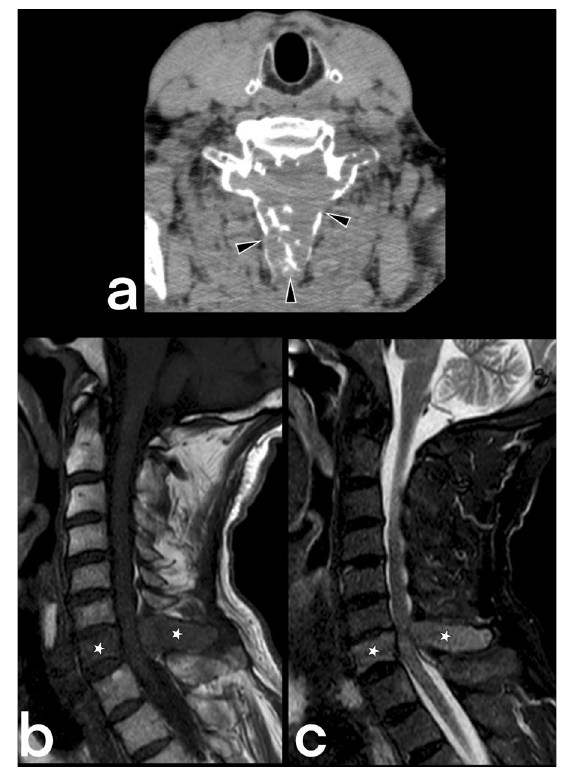
Fig. 46 A 41-year-old male with pain in the posterior neck region. Non-contrast axial CT image ( a ) demonstrates destruction and bone erosion of the posterior spinous process of the C7 vertebra (arrowheads). Pre-contrast sagittal T1 weighted image ( b ) reveals diffuse decreased signal intensity within the c7 vertebral body and posterior spinous process. The lesion shows prominent diffuse contrast enhancement on sagittal ( c ) T1-weighted images